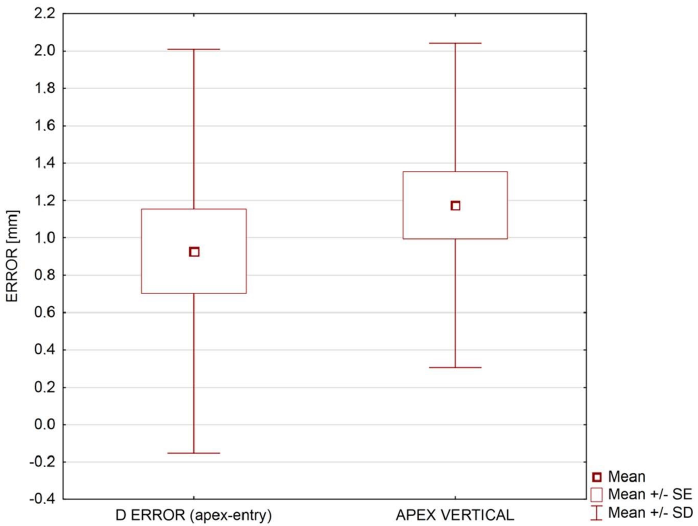
Figure 7. The comparison of TOTAL ERROR APEX VERTICAL value with ∆ ERROR Figure 8. The comparison of TOTAL ERROR APEX VERTICAL value with ∆ ERROR (apex-entry).